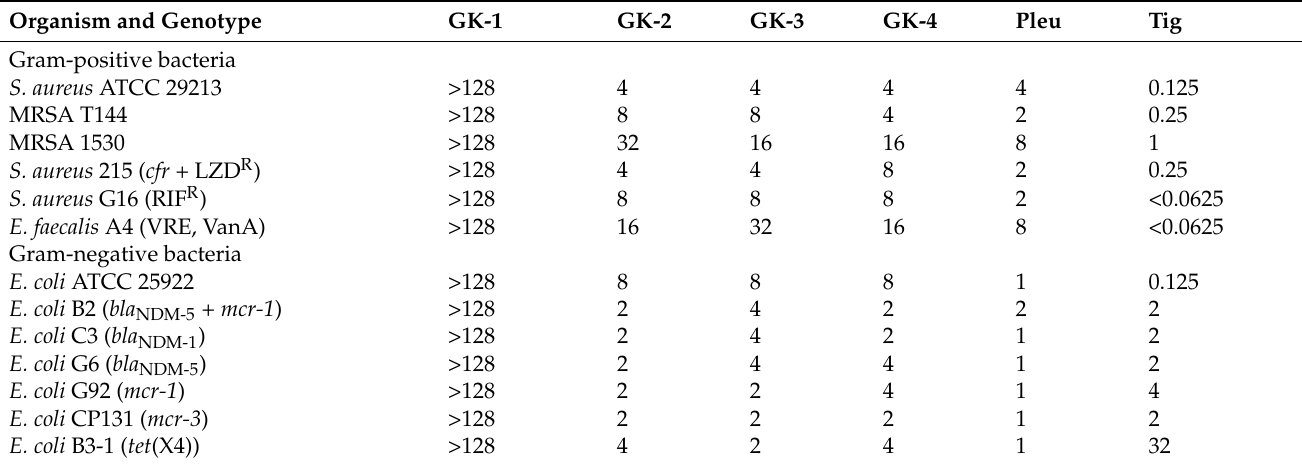
Figure 1. Design and characterization of Pleu and its modified peptides. ( A ) The amino acid sequences of different peptide mutants. ( B ) Helical wheel projections of peptides. Amino acids in blue are positively charged, while in yellow are hydrophobic. Table 1. Key physicochemical parameters of amphipathic peptides. Table 2. Antibacterial activity of Pleu and its modified peptides against a panel of MDR pathogenic bacteria (MIC, µ